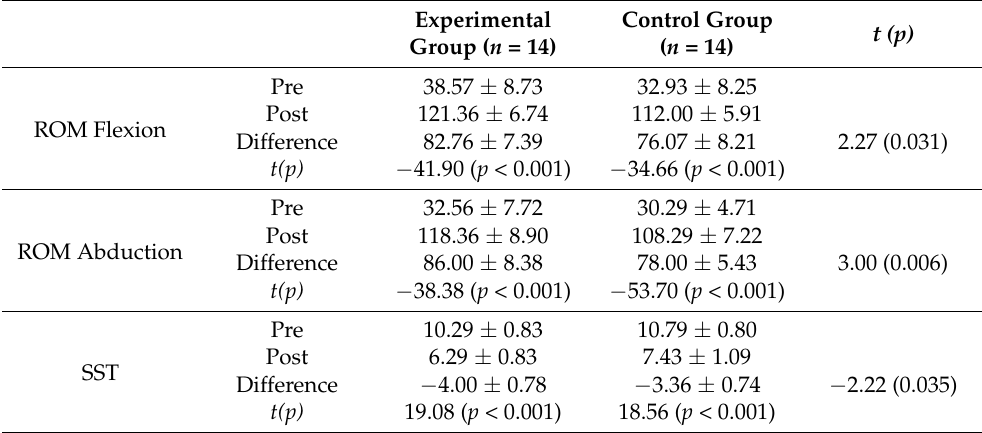
Table 3. Changes in shoulder function before and after treatment ( n =